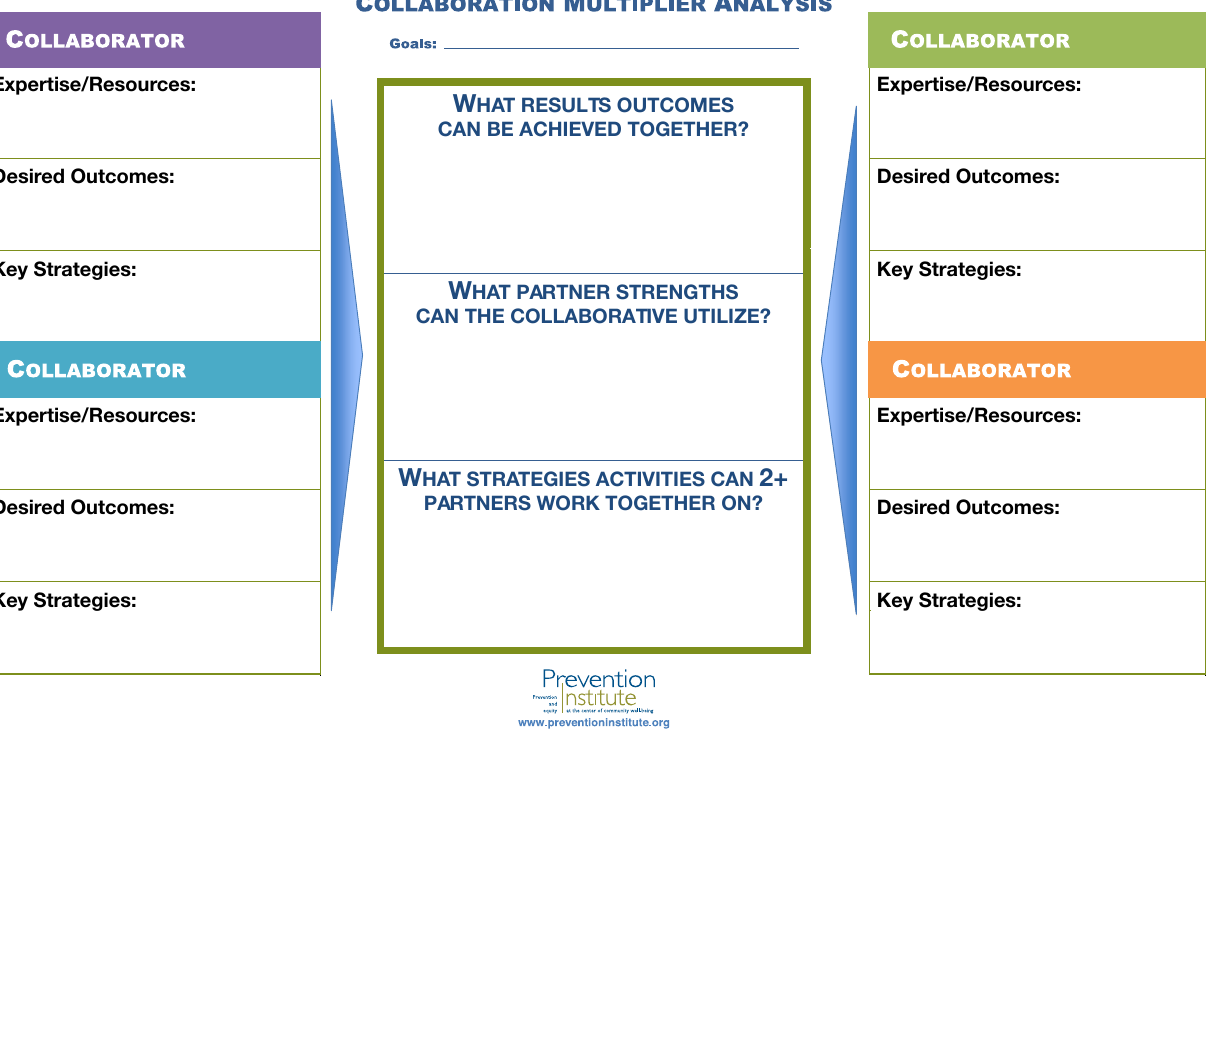
FIGURE 4. COLLABORATION MULTIPLIER Prevention Institute. Collaboration Multiplier Analysis Worksheet. (2011, July). Used with